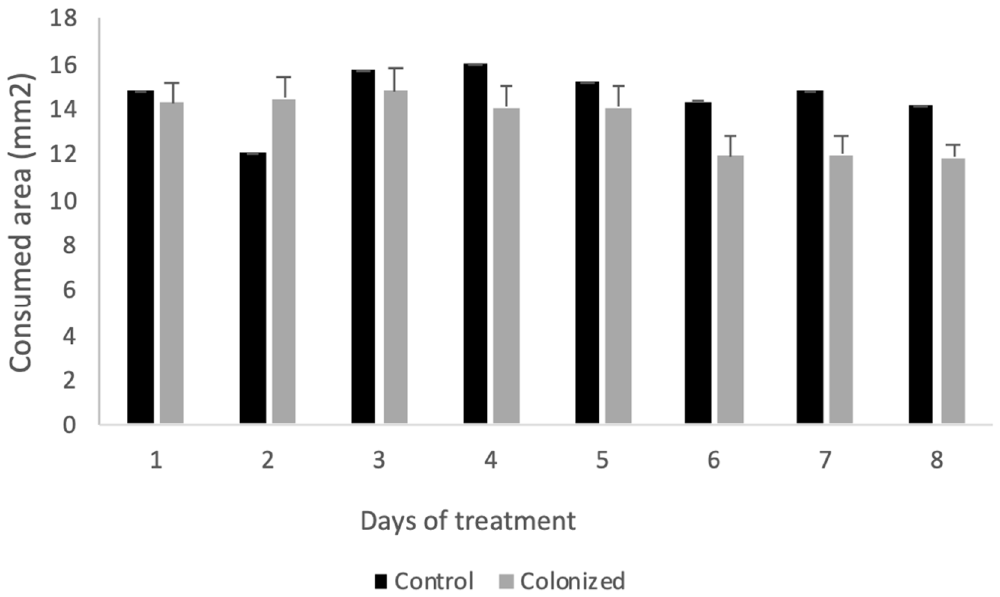
Figure 3. Mean area (mm 2 ) of control and Metarhizium -colonized discs consumed by S. littoralis larvae during the experiment (8 days). Bars indicate ± SE. n control = 720, n colonized = 720.